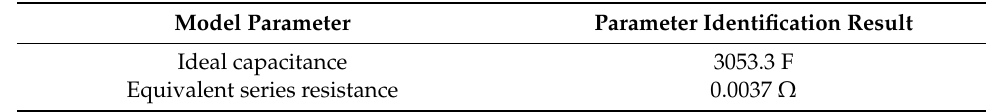
Table 4. Parameter identification of the ultracapacitor.